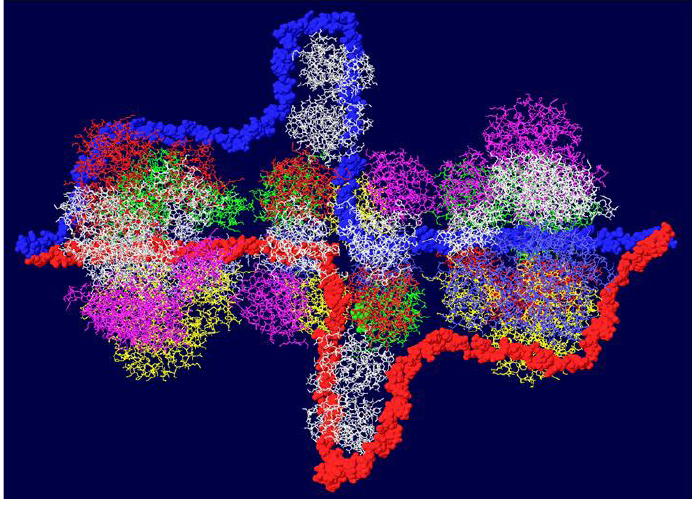
Figure 6. Complete model of single-stranded DNA threading in DH and associated RPA 70. Each DNA strand is shown going through the central channel of one hexamer, passing through a side hole of the OBD DH and going through RPA and around the other helicase domains. RPA is shown in white at the top and